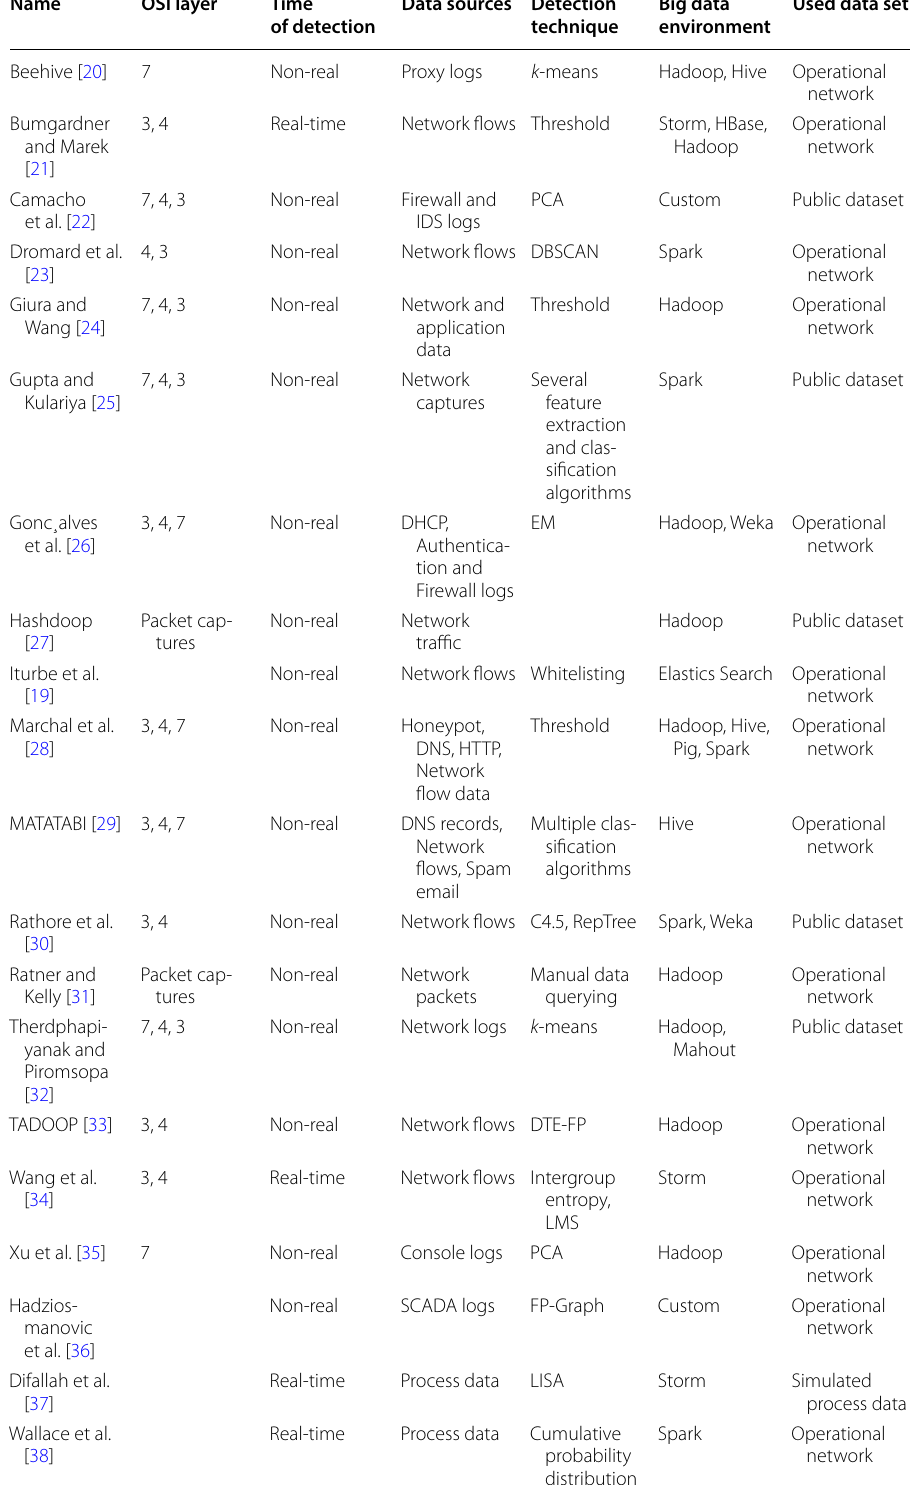
Table 3 Done experiments on IDS optimization using big